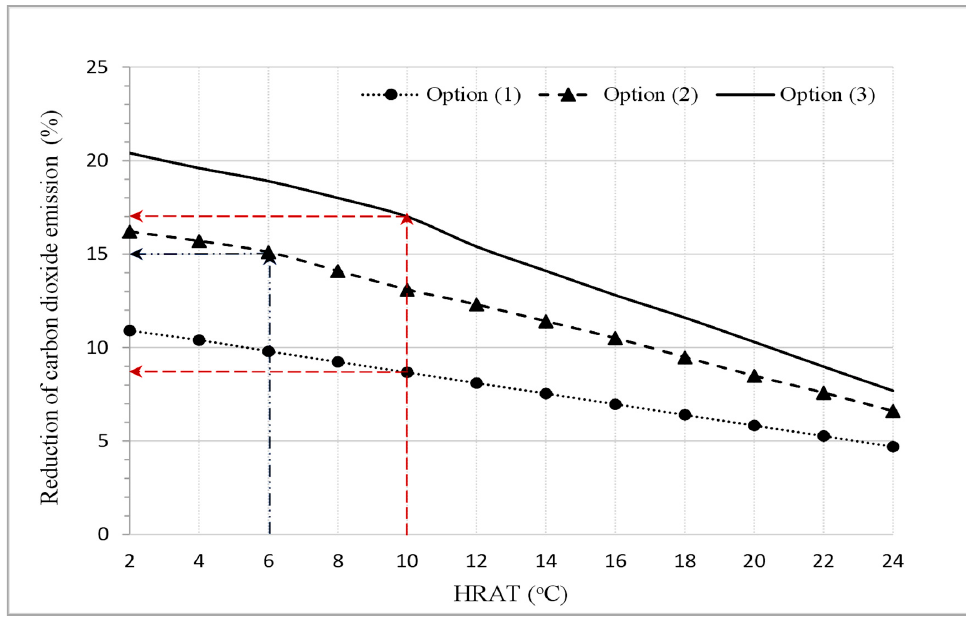
Figure 9. Emission reduction for the three options.